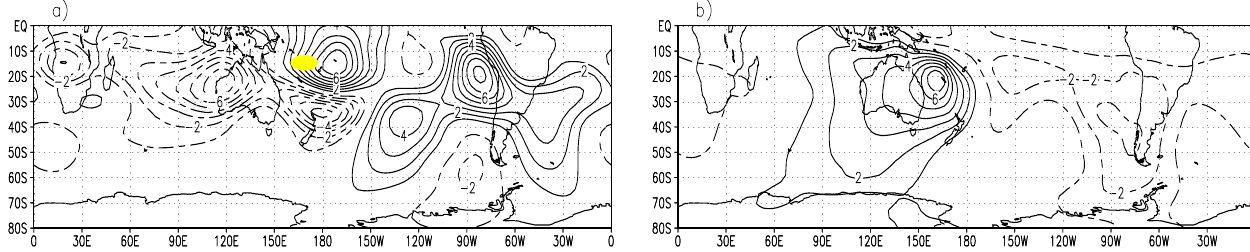
Fig. 1. Stream function anomalies (1 × 10 − 6 m 2 s − 1 ) at 250hPa (a) and 850hPa (b) , on day 10 of integration, corresponding to the mean Figure 1 : Stream function anomalies (1x10 -6 m 2 s -1 ) at 250 hPa (a) and 850 hPa (b), on day 10 of winter state basic experiment with a forcing at 170 ◦ E–15 ◦ S (see dot in the figure). integration, corresponding to the mean winter state basic experiment with a forcing at 170ºE-15ºS (see gray dot in the figure)